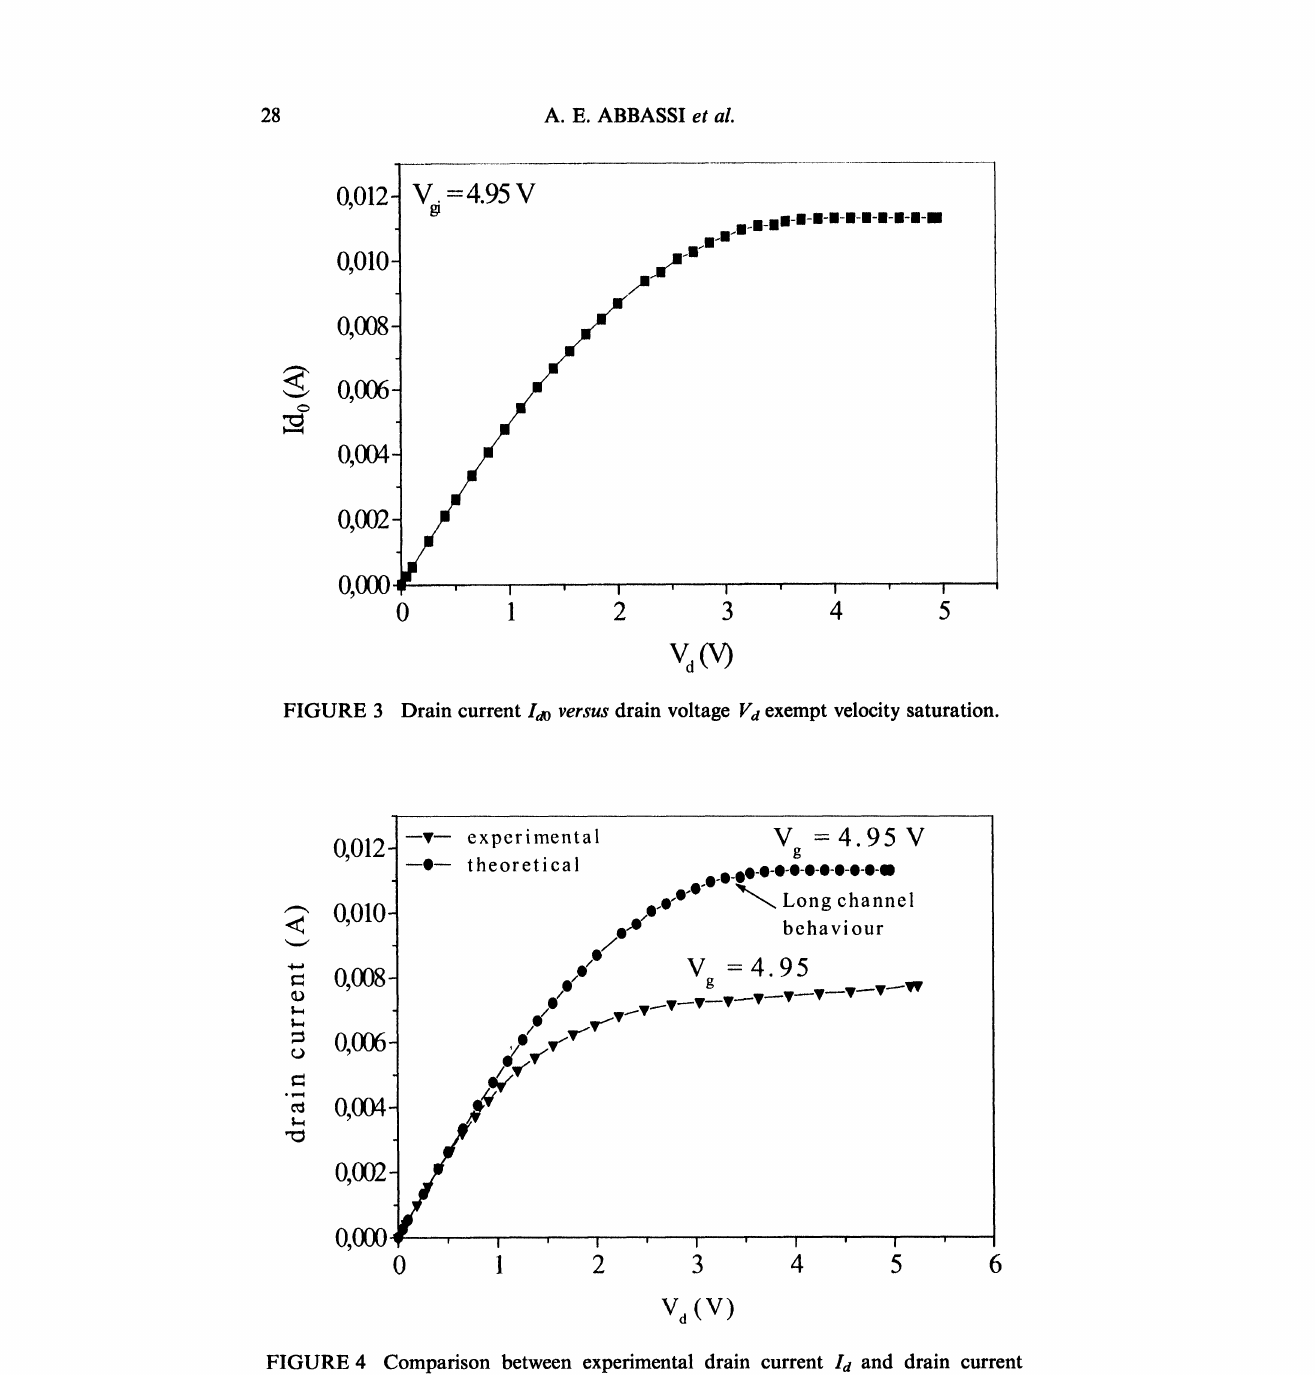
FIGURE 4 Comparison between experimental drain current Ia and drain current model Iao versus drain voltage